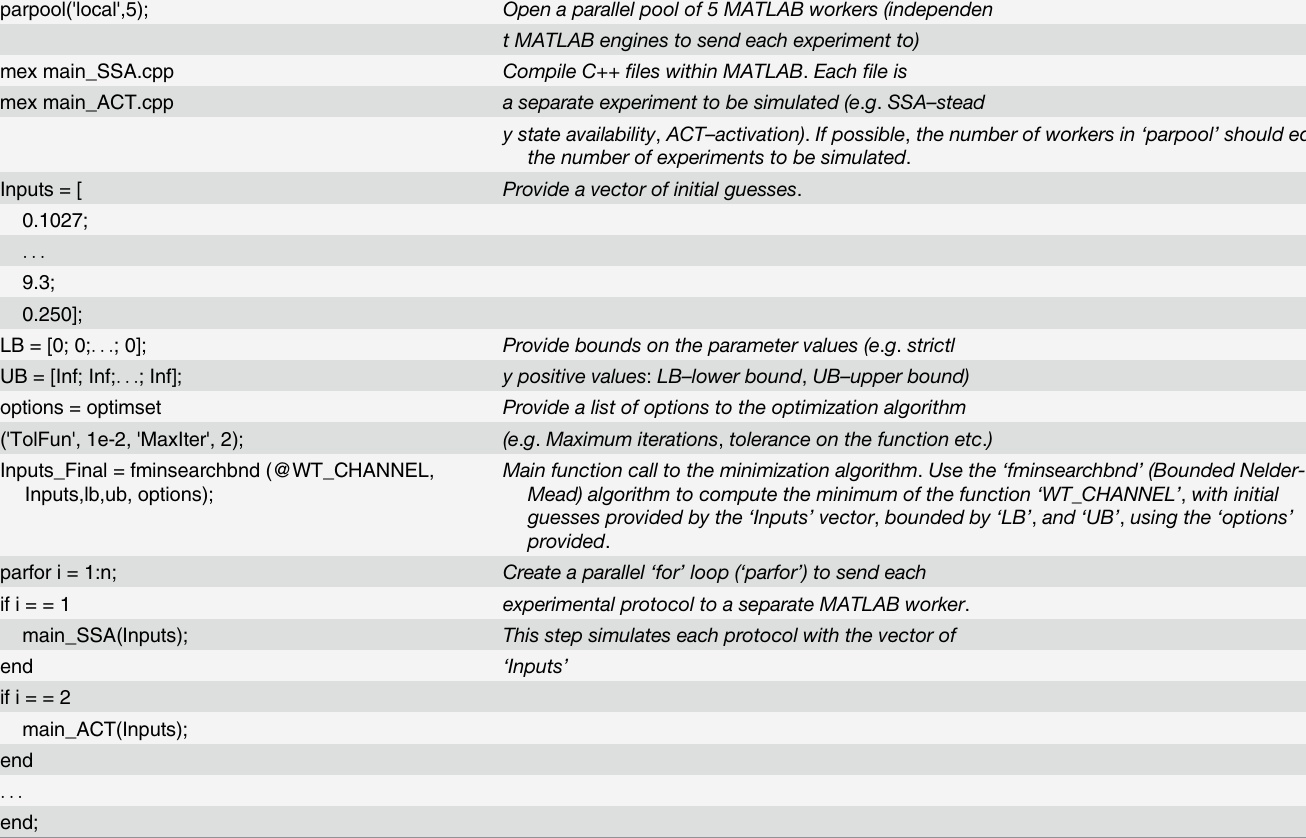
Table 2. Example Code and Key Commands.